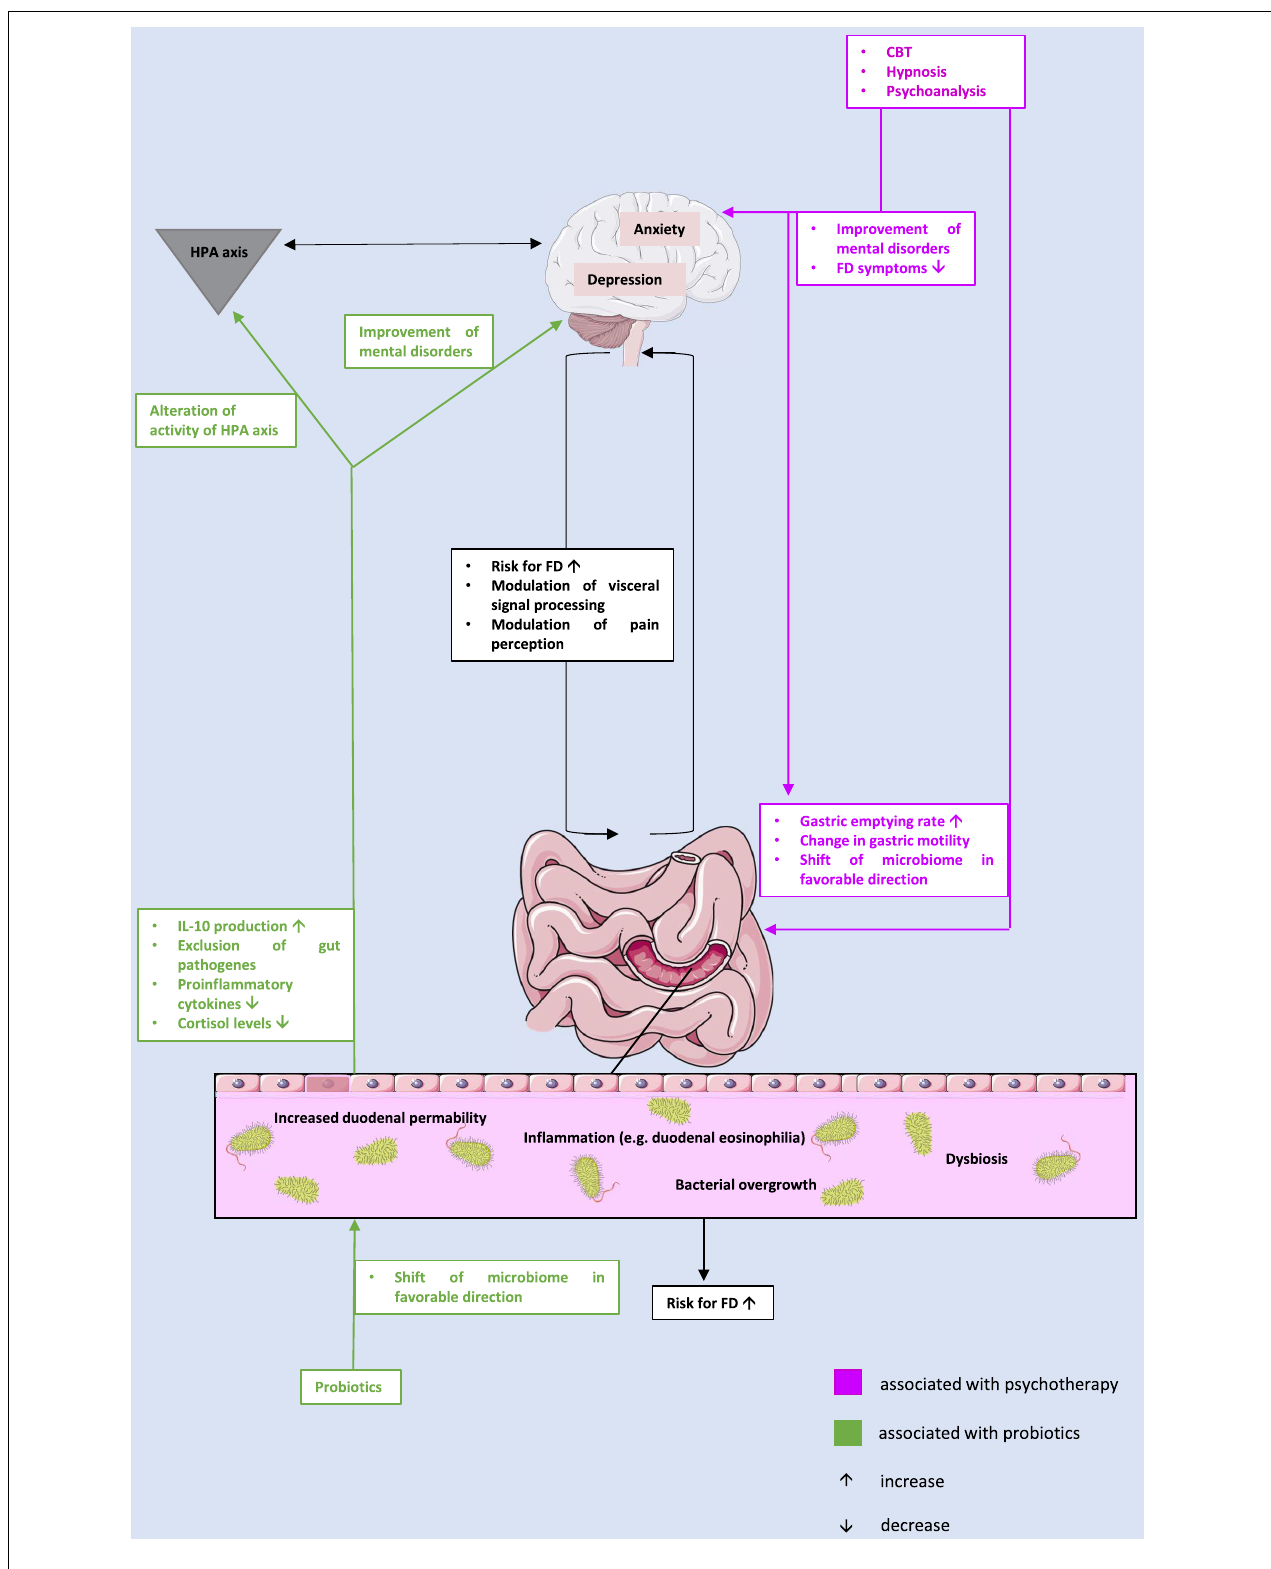
FIGURE 1 | The potential interplay between microbiome, gut, and brain in the context of the pathophysiology of functional dyspepsia and treatment approaches. CBT, cognitive behavioral therapy; FD, functional dyspepsia; HPA, hypothalamus-pituitary-adrenal; IL, interleukin.